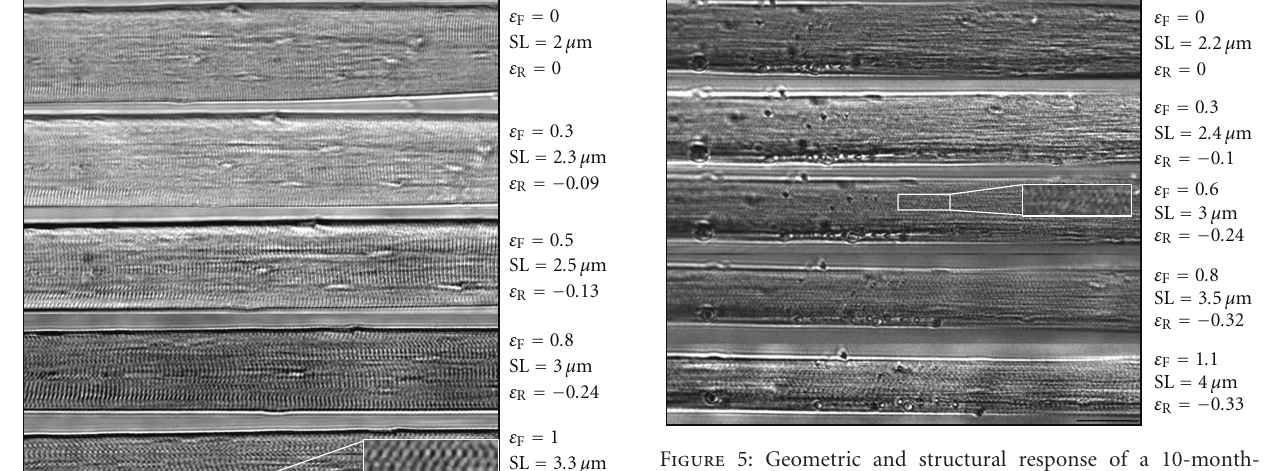
Figure 5: Geometric and structural response of a 10-month- old desmin-null fiber to tensile loading. The same region of the fiber, imaged using phase-contrast microscopy, is shown at five di ff erent deformations. Fiber strains, radial strains, and sarcomere lengths are reported to the right of the fiber for each deformation. The fiber displays misaligned Z-lines, but consistently increasing sarcomere strain and decreasing fiber diameter with increased fiber deformation with increased fiber deformation. Misalignment is characterized by a striking basketweave pattern where no clear Z- line orientation may be inferred. A sample region of the fiber that displays this pattern is marked with a white box, and may be compared to the well aligned region shown in Figure 4. The boxed region has been computationally enlarged 2x for clarity. fiber dissection, possibly resulting from di ff erences in extracellular matrix composition. Bar = 50 μ